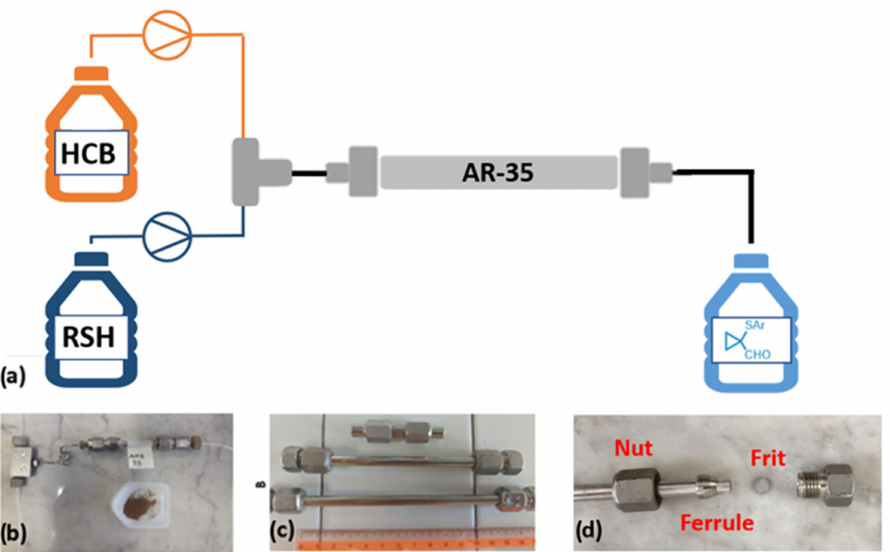
with high flow rates, resulting in low conversions of the corresponding adduct 3a (entry 1), Table 2. Reducing the flow rates led to an improvement in the conversion (entry 2). Keeping the flow rate constant and using 0.1 M solutions of 1a and 2a , we were able to obtain better results, reaching conversions equal to 75% (entry 3). Further reductions of the flow rate to 0.3 mL/min allowed us to increase the conversion to a maximum of 90% (entry 4). The